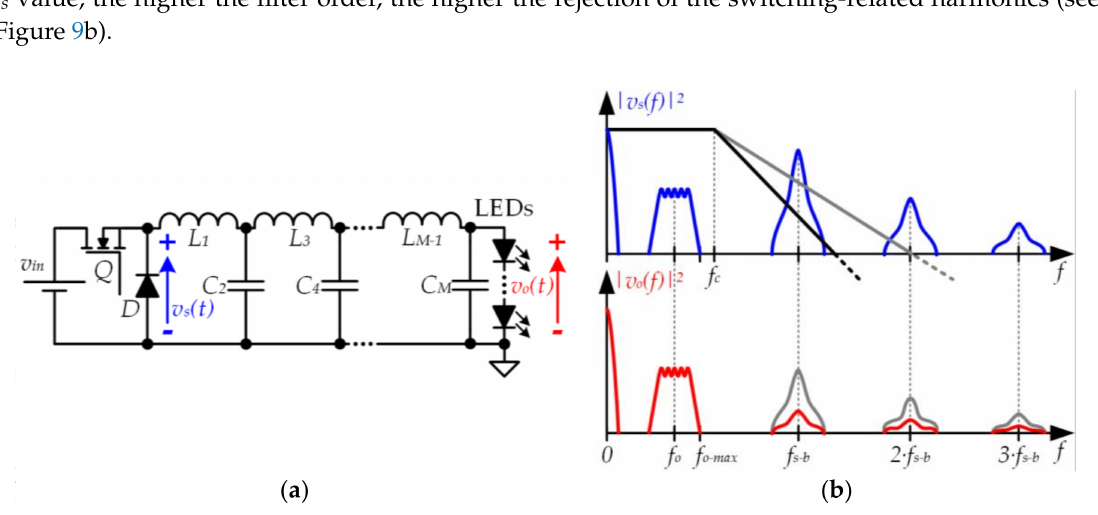
Figure 9. ( a ) Buck converter with M th -order output filter; ( b ) The output voltage ripple can be reduced by increasing the filter